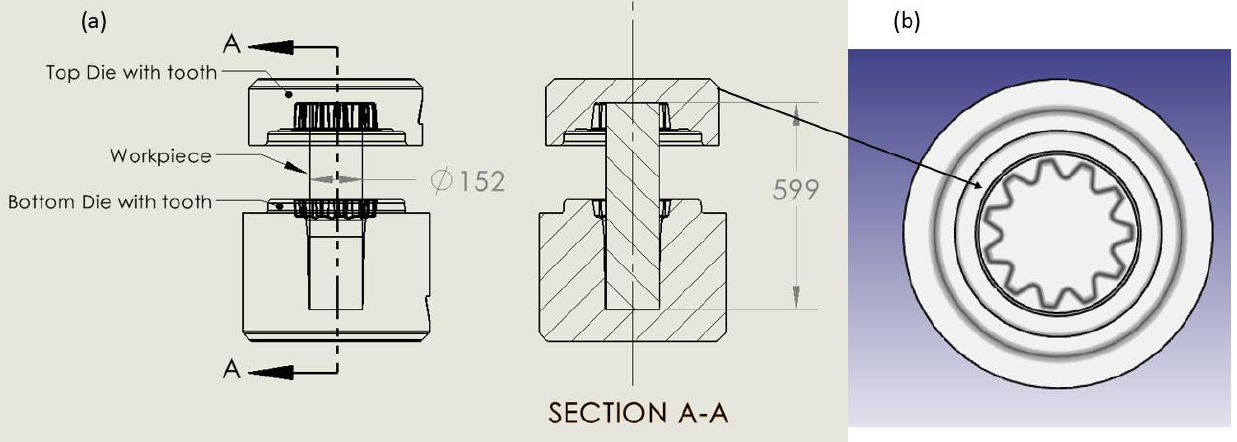
Figure 14. ( a ) Schematics of near-net-shape forging, ( b ) Top die with gear teeth incorporated. Dimensions in mm.